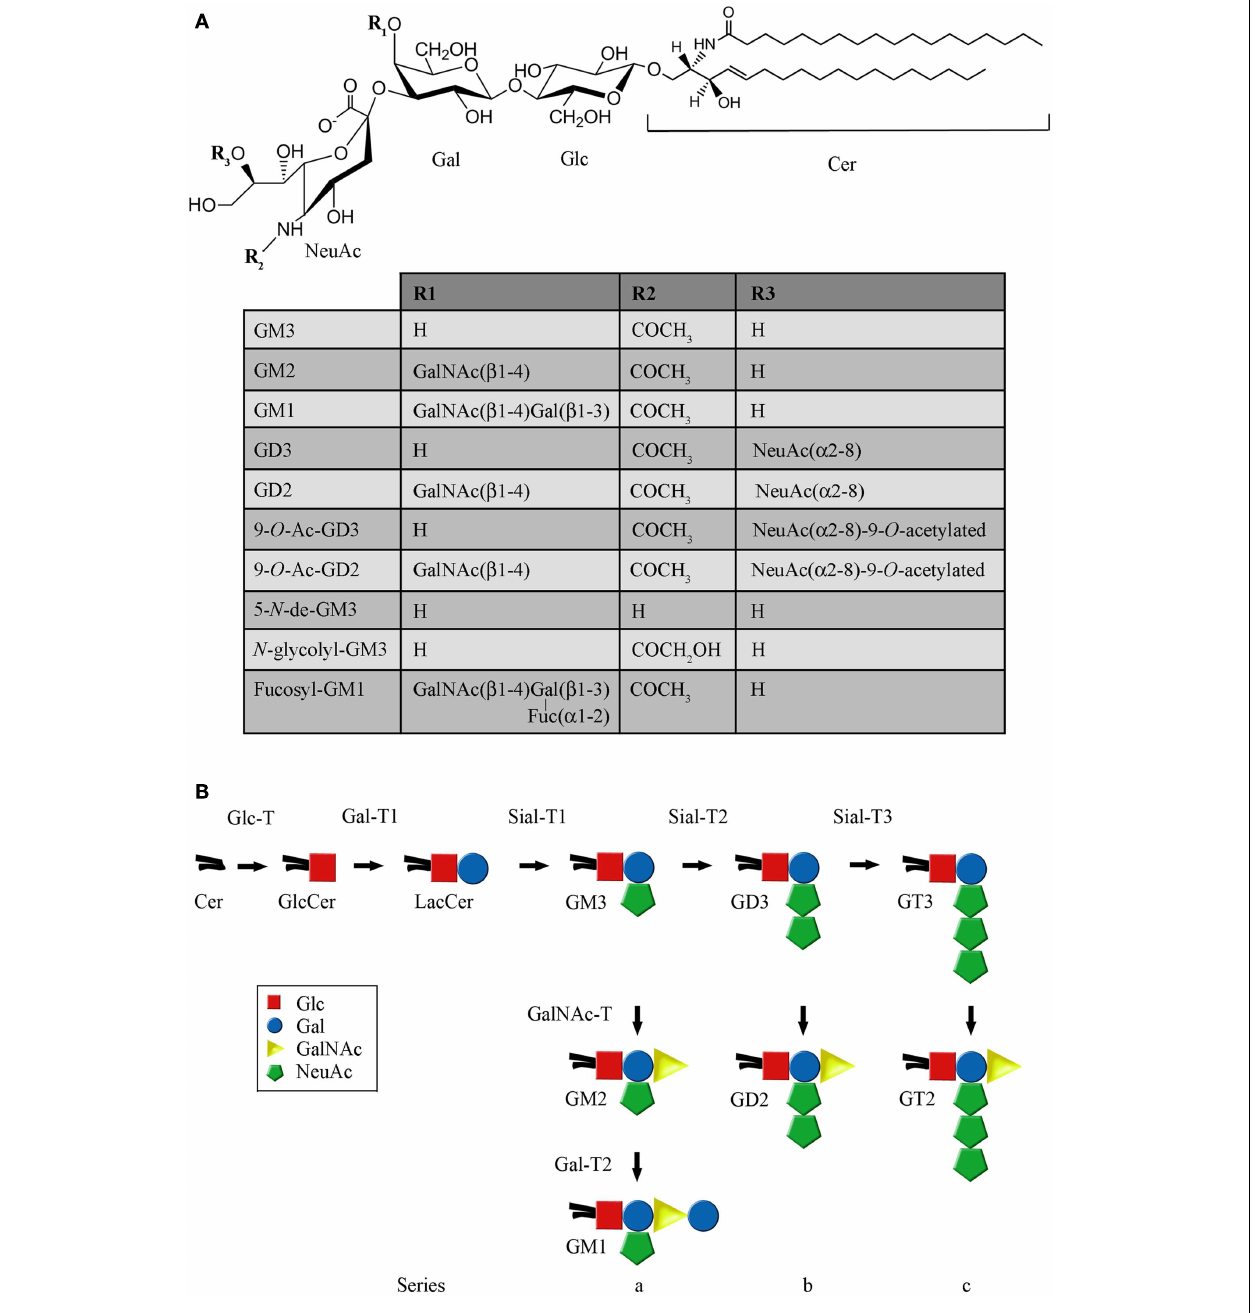
intranuclear calcium homeostasis (2). Gangliosides are expressed in cell-type and developmental-specific patterns, and are major components of nerve cells, where they may represent more than 10% of the total lipid content. Moreover, on the neuronal surface, they contribute more than 30% of the N -acetylneuraminic acid (Neu5Ac or sialic acid) (3–5).